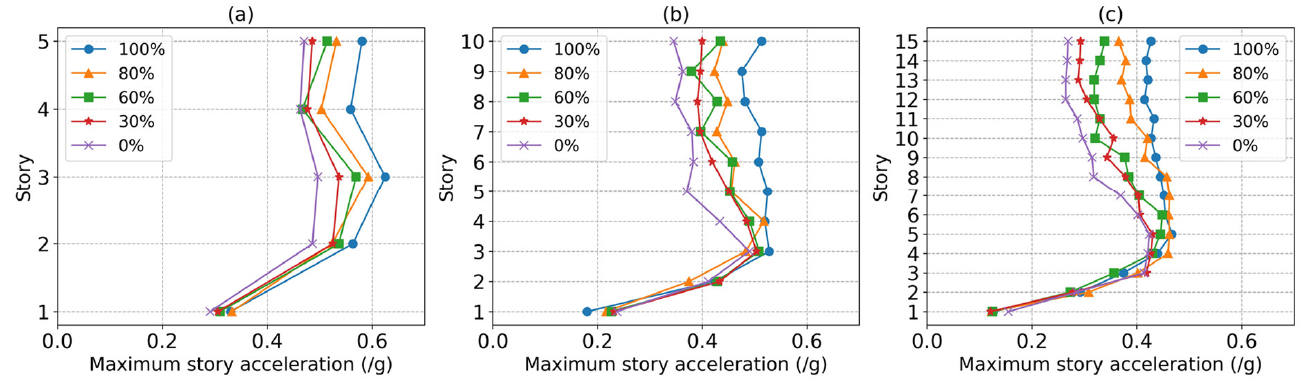
Figure 22. Peak story acceleration; ( a ) 5 stories; ( b ) 10 stories; and ( c ) 15 stories.